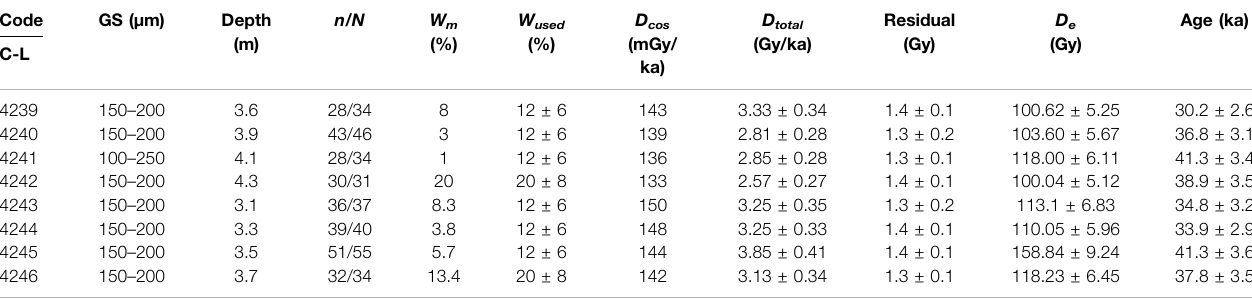
TABLE 1 | Summary of the luminescence data of the potassium feldspar samples from At trench 5 and trench 3B. The used grain size (GS), depth considering erosion of ∼ 1.6m, number of accepted (n) and measured (N) aliquots measured (W m ) and used (W used ) water contents, cosmic (D cos ) and total dose rates (D total ), residual doses, equivalent doses (D e ) and ages are shown.